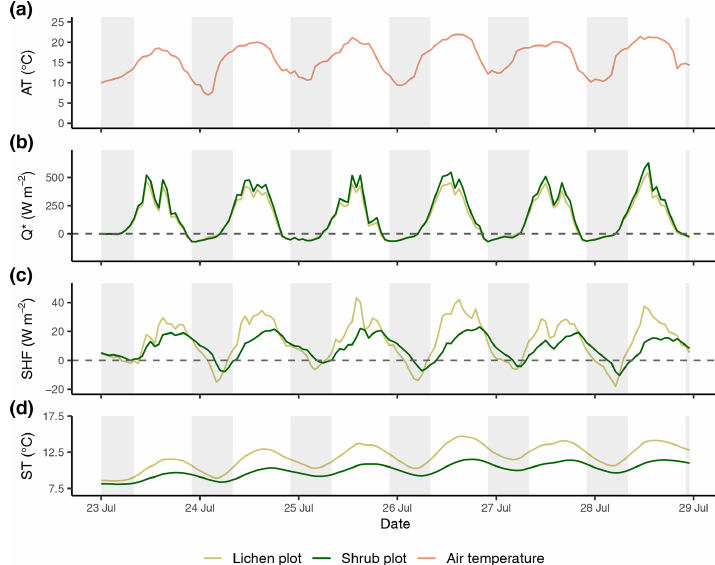
Figure E2. Time series of the reference air temperature (a) , net radiation (b) , soil heat flux (c) and soil temperature (d) of the second set of paired plots of the field season of 2019. Time series are constructed with hourly averages. Shaded areas indicate nighttime (22:00–08:00LT). AT: reference air temperature; Q ∗ : net radiation; SHF: soil heat flux; ST: soil